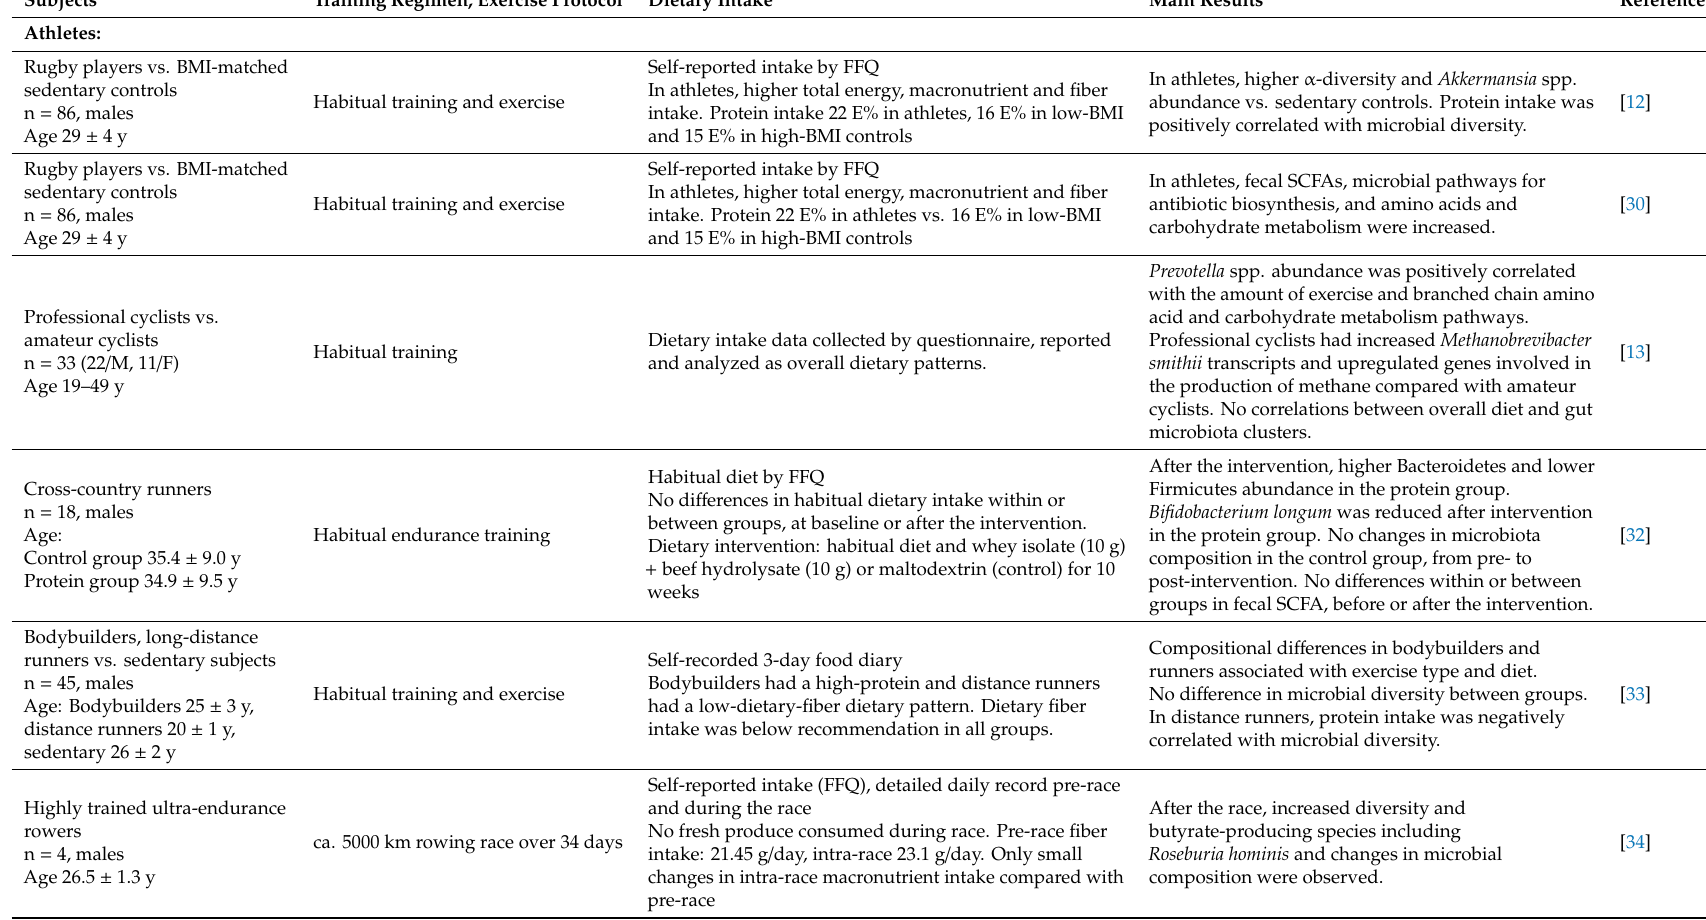
Table 1. Studies on exercise and gut microbiota conducted in athletes, physically active individuals and sedentary